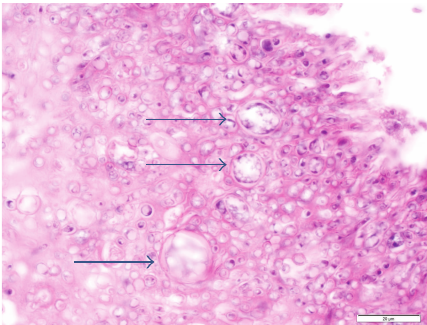
Figure 1: HE stain (100x) demonstrating bulbous forms. Figure 2: GMS stain (100x) demonstrating fungal